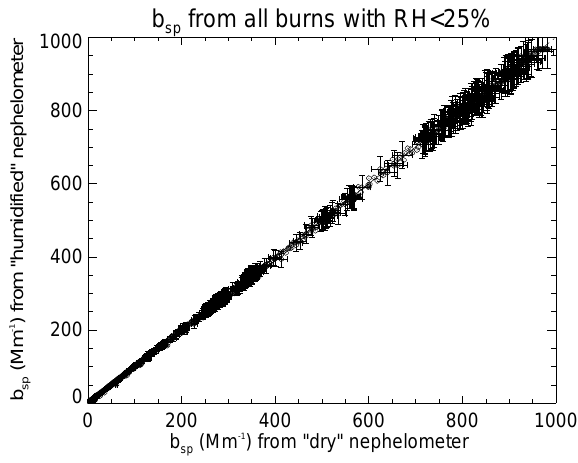
Figure 1. Comparison of dry (RH<25%) b sp (Mm -1 , wavelength of 530 nm) for ten burns. Fig. 1. Comparison of dry (RH < 25%) b sp (Mm − 1 , wavelength of 530nm) for ten